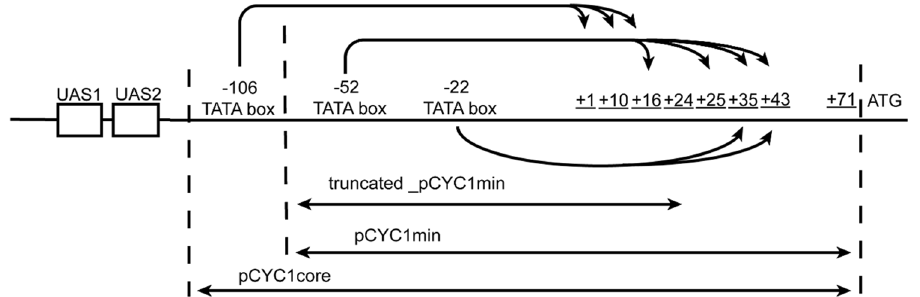
Figure 2. Scheme of CYC1 promoter and its shorter derivatives used in this work. The number from + 1 to + 43 represent different TSSs (transcription start sites). Arrows with multiple tips on the right indicate all TSSs that are activated by the same TATA box (usually, they lie from 40 up to 120 nt downstream of the TATA